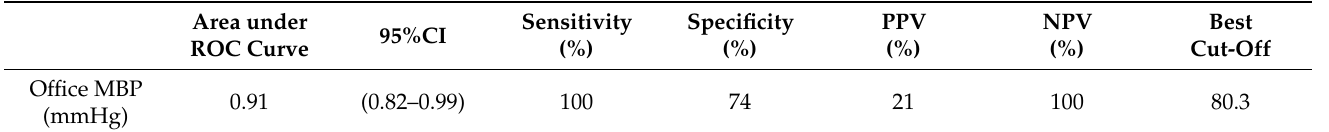
Table 7. Area under curve ROC (95%CI) for the prediction of PE by determination of office MBP in the first trimester in normotensive pregnant women.